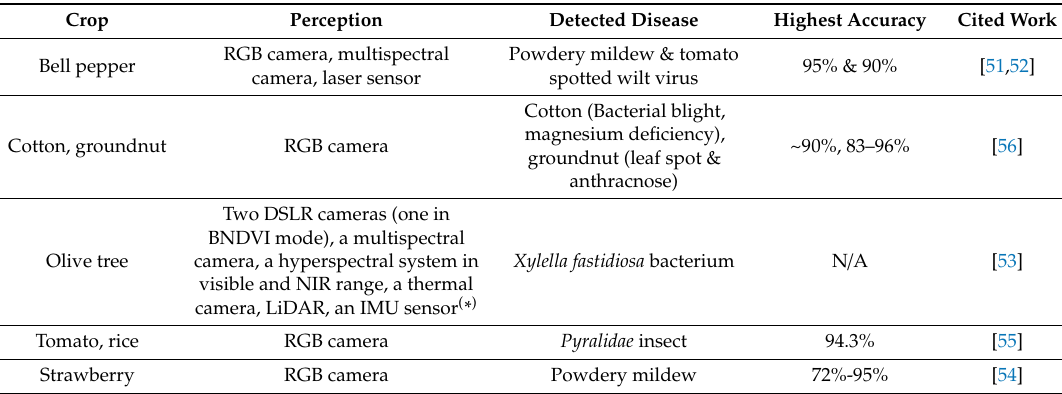
Table 3. Disease and insect detection agrirobotic systems features for various